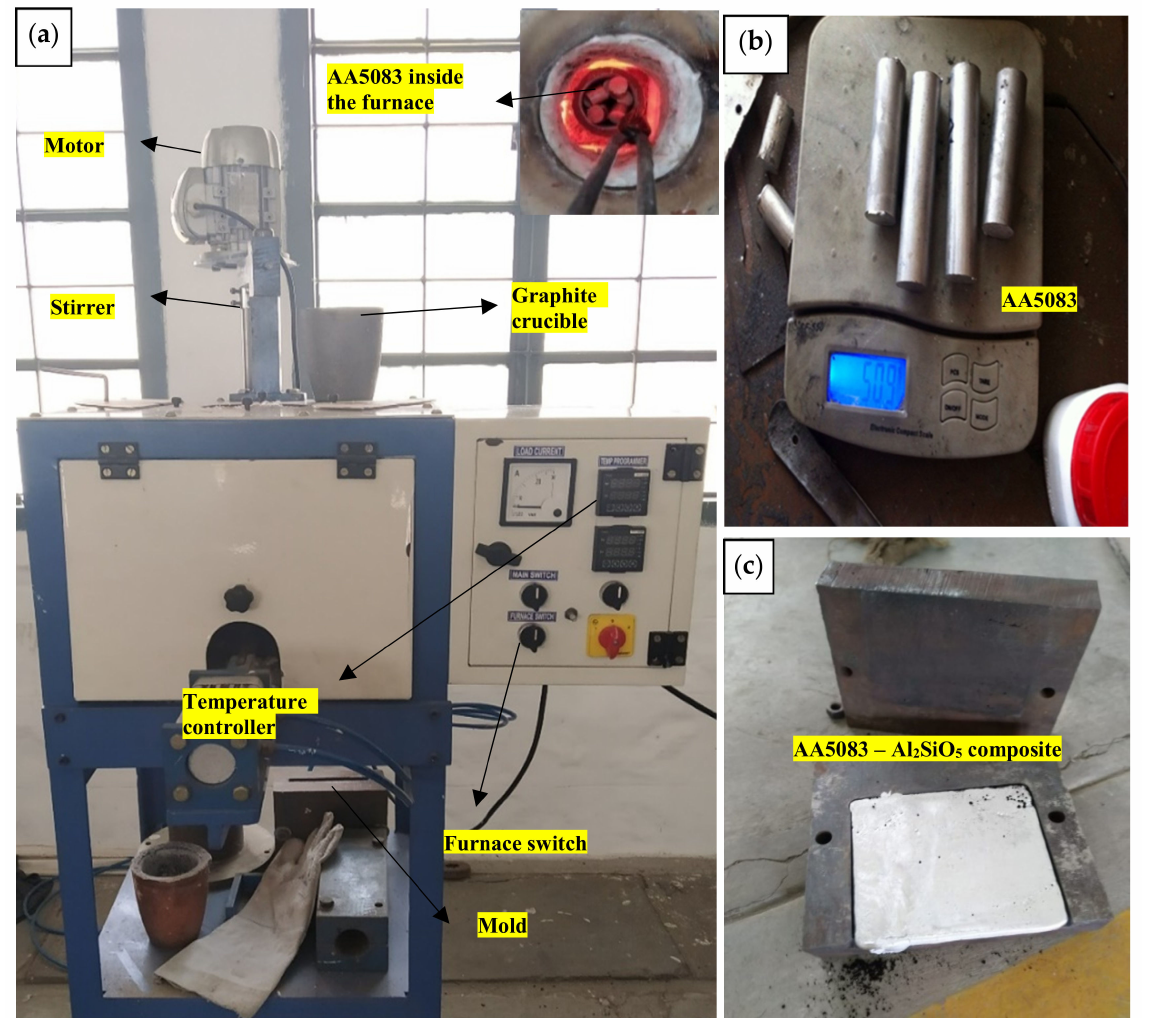
Figure 1. Casting equipment: ( a ) experimental compo-casting setup; ( b ) matrix material; ( c ) AA5083— Al 2 SiO 5